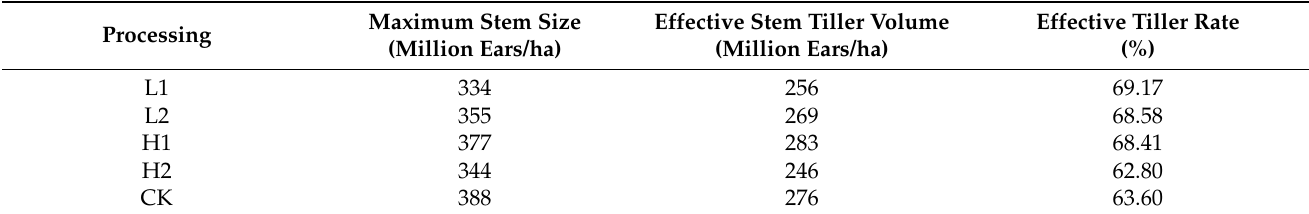
Table 2. Characteristics of rice stem tillers for water level management at the tiller